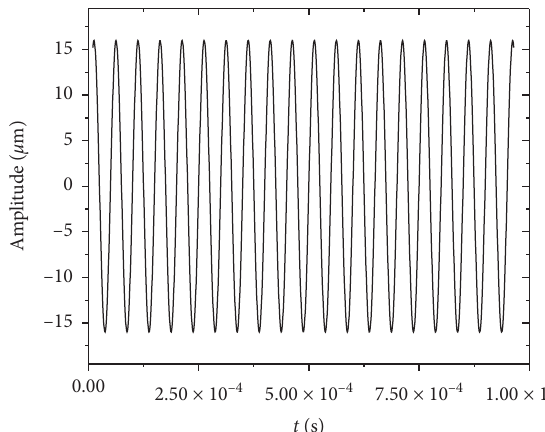
Figure 17: Fixed-frequency longitudinal